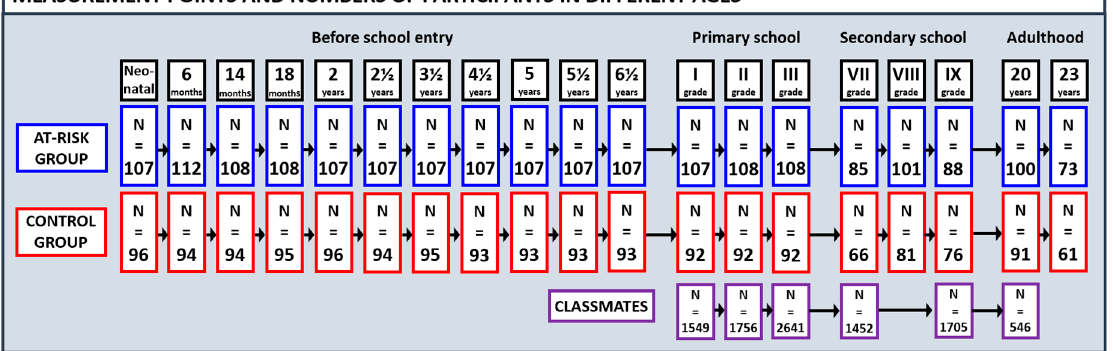
Figure 2. Measurement points and numbers of participants at each age phase.